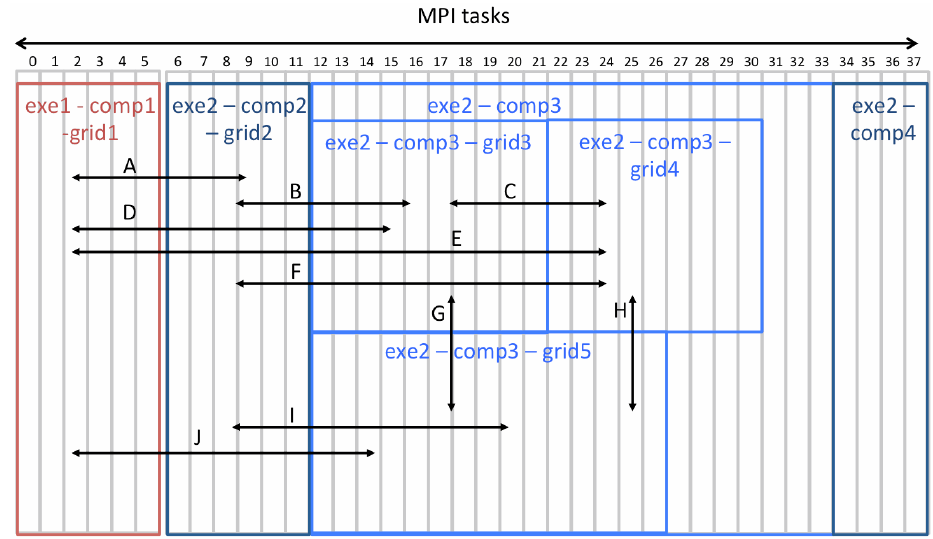
Figure 1. A schematic of the coupling capability in OASIS3-MCT_3.0. In this example, there are two executables, exe1 and exe2. exe2 has three components, comp2, comp3, and comp4, and comp3 has three grids, grid3, grid4, and grid5; comp4 is not involved in any coupling in this case. The executables, components, and grids are laid out across different tasks. Arrows indicate different coupling capabilities: A, D, E, and J between different components in different executables; B, F, and I in a single executable between different components with different grids; C between different grids in a single component on non-overlapping tasks; G between different grids in a single component on partially overlapping tasks; and H between different grids in a single component on partially overlapping and partially non-overlapping